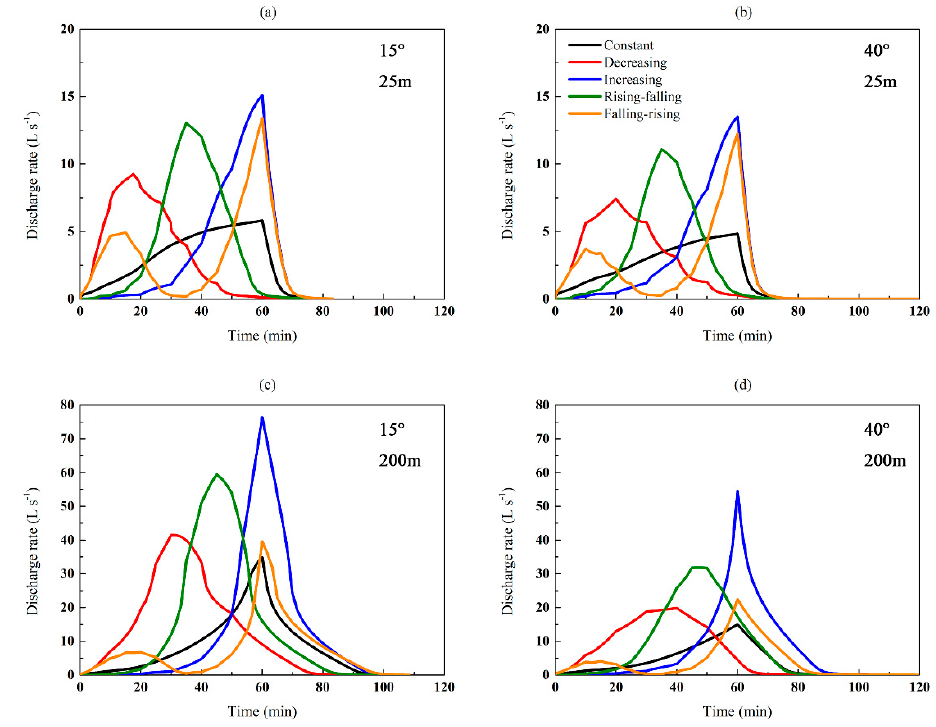
Figure 4. The hydrographs of five different rainfall patterns with 25 m and 200 projective slope lengths at 15° slope ( a , c ) and 40° slope ( b , d ), respectively.